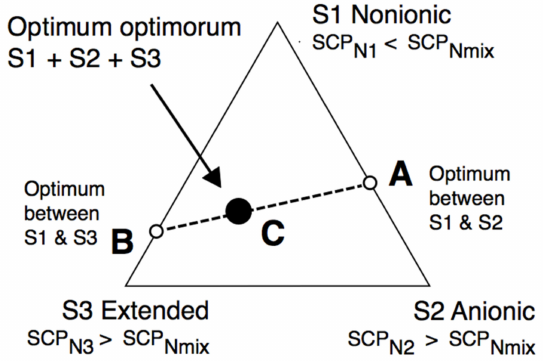
Figure 6. The synergetic optimum formulation is often attained with three surfactants when one of them is an extended species, at other constant variables (S, ACN, T, P,